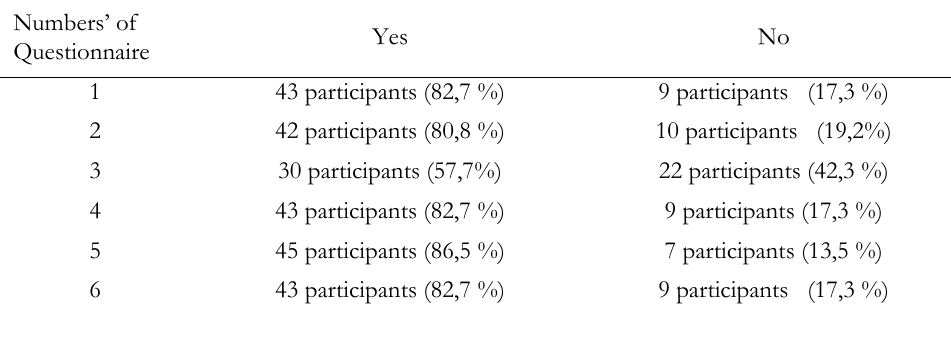
Table 2. The Result of